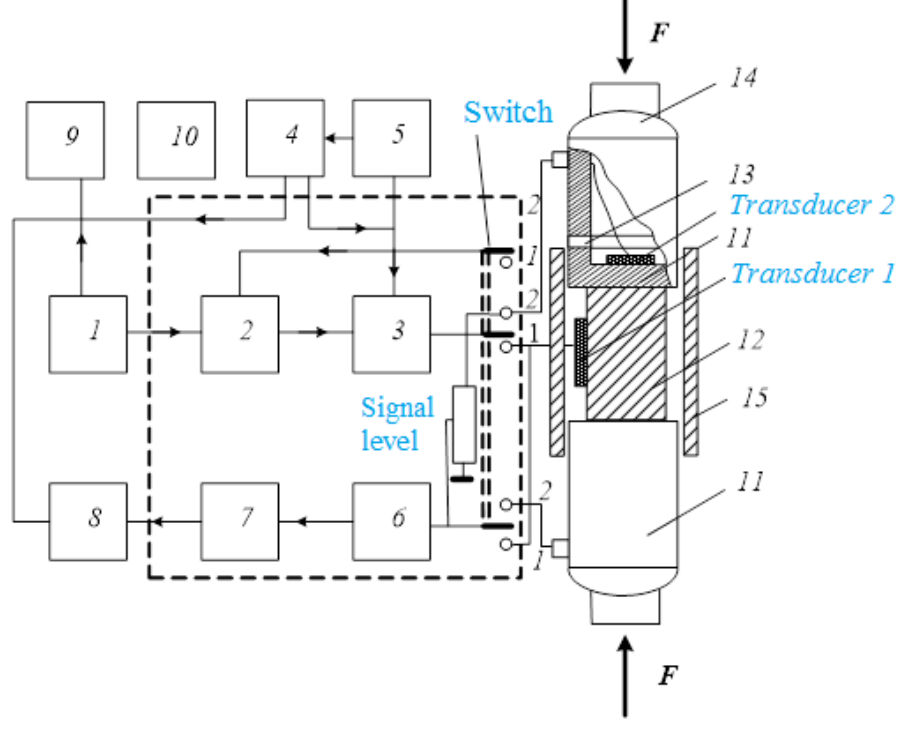
Figure 3. Block diagram of the experimental setup. 1—master oscillator, 2, 3—modulator, 4, 5—pulse oscillators, 6—attenuator, 7—amplifier, 8—oscilloscope, 9—frequency meter, 10—computer, 11—delay lines, 12—specimen, 13—ceramic rings, 14—spherical hinges, 15—thermostatic